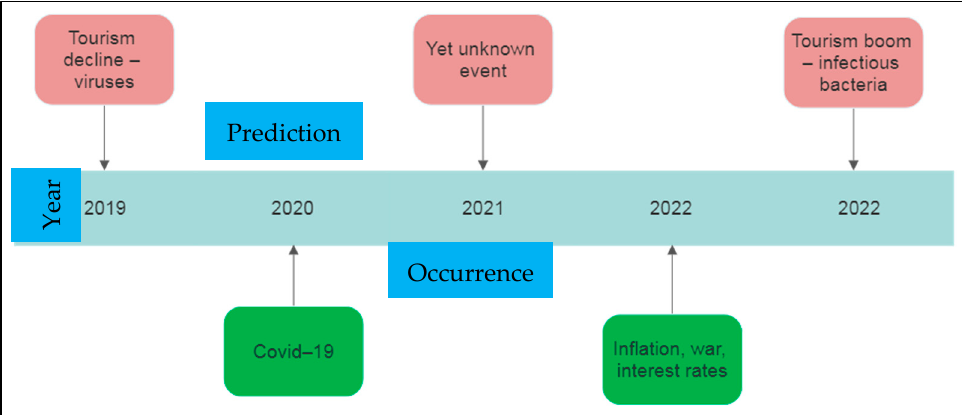
Figure 1. A timeline of pre-emptive approach (red) and shock response (green). Source: Compiled by authors based on Gricar et al. (2022).